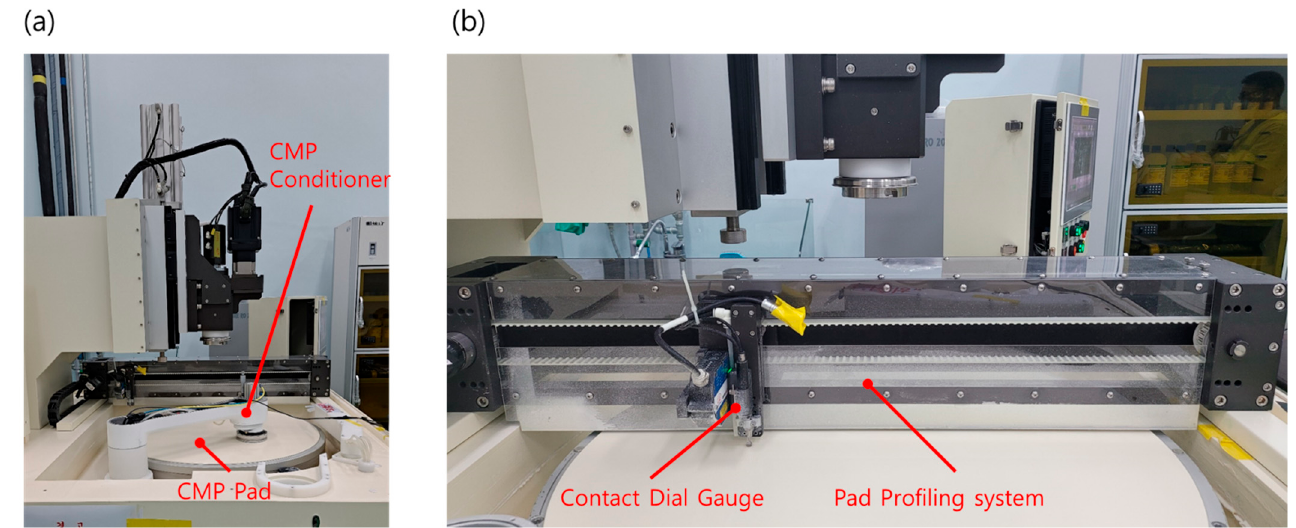
Figure 1. ( a ) Chemical mechanical polishing (CMP) conditioning equipment ( b ) profiling system.